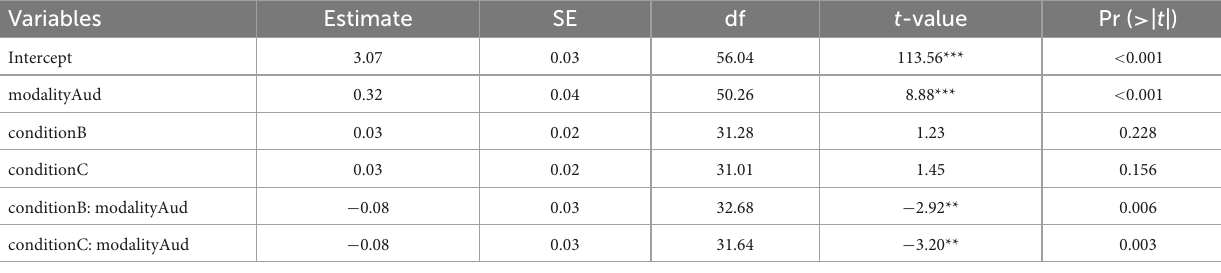
TABLE 5 Results of LME model analysis of reaction times in the semantic transparency